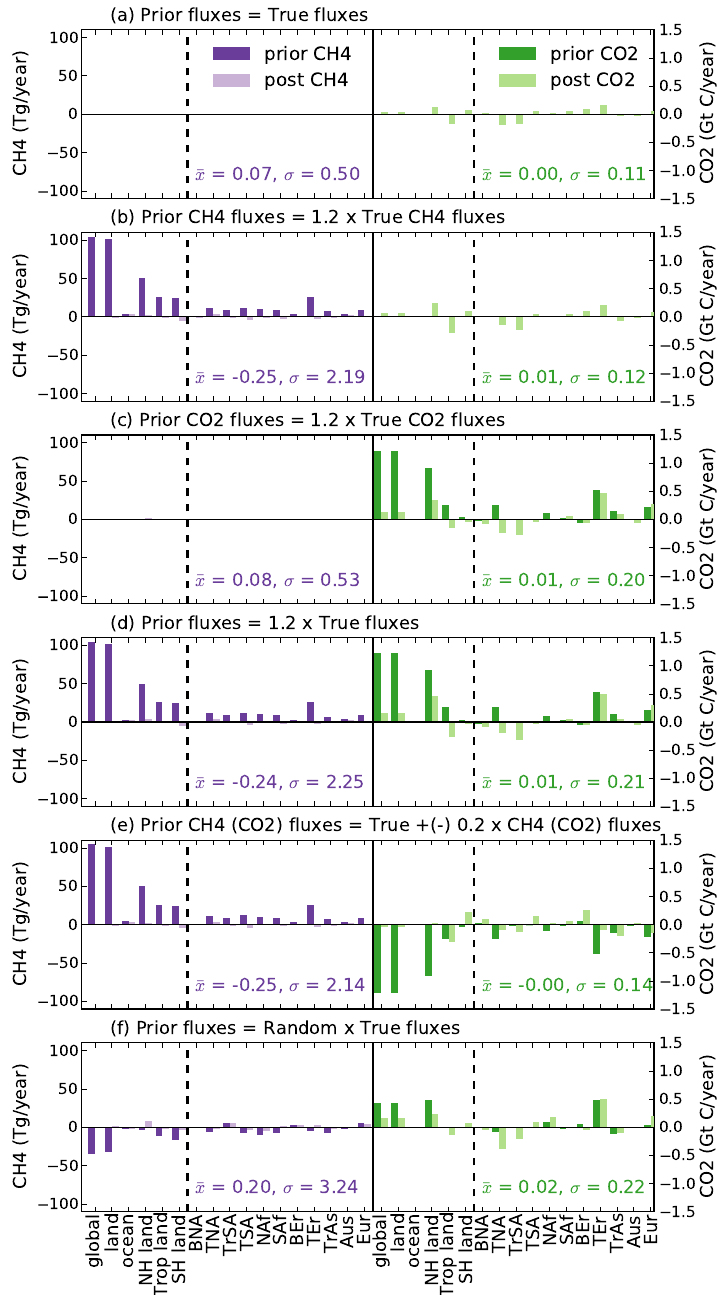
Figure 7. As Fig. 6 but all experiments use CH 4 and CO 2 surface flask data and GOSAT data. For experiment (a) a priori fluxes are equal to the true fluxes; for experiment (b) CH 4 a priori fluxes are 20% larger than the true fluxes; for experiment (c) CO 2 a priori fluxes are 20% larger than the true fluxes; for experiment (d) CH 4 and CO 2 a priori fluxes are 20% larger than their true fluxes; for experiment (e) CH 4 a priori fluxes are 20% larger and CO 2 a priori fluxes are 20% smaller than their true fluxes; and for experiment (f) all a priori fluxes are perturbed stochastically, ranging from − 20 to 20%, from the true Fig. 7. As Fig. 6 but all experiments use CH and CO surface flask data and GOSAT data. Experiment (a) 4 2 for which a priori fluxes are equal to the true fluxes; experiment (b) for which CH a priori fluxes are 20 % 4 larger than the true fluxes; experiment (c) for which CO a priori fluxes are 20 % larger than the true fluxes; 2 experiment (d) for which CH and CO a priori fluxes are 20 % larger than their true fluxes; experiment (e) for 4 2 which CH a priori fluxes are 20 % larger and CO a priori fluxes are 20 % smaller than their true fluxes; and 4 2 experiment (f) for which all a priori fluxes are perturbed stochastically, ranging from 20 % to 20 %, from the − true fluxes.